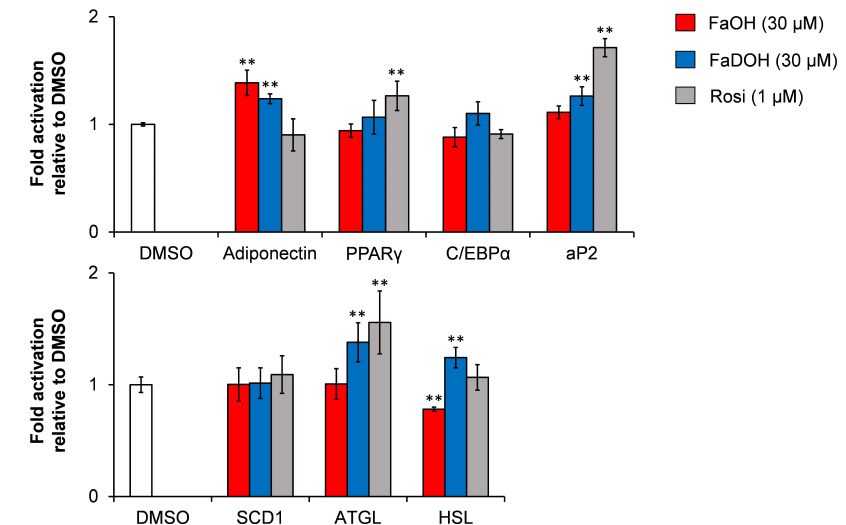
Figure 8. Effect of FaOH and FaDOH on gene expression of key proteins involved in adipogenesis (PPAR γ , C/EBP α , aP2), lipogenesis (SCD1), lipolysis (ATGL, HSL) and the adipokine adiponectin in mature 3T3-L1 cells. Rosi was the positive control. All values are normalized to the vehicle 0.1% DMSO and are expressed as a mean ± SD of three independent experiments in triplicates. ** p < 0.001 indicates significance relative to 0.1%